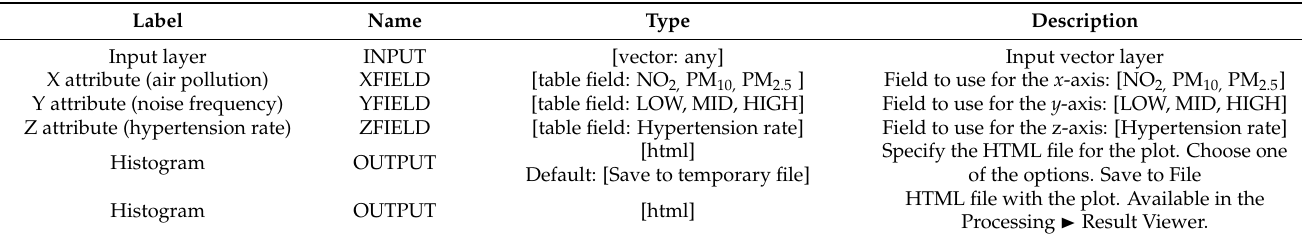
Table 1. Parameters for creating a 3D scatterplot for the vector layers.